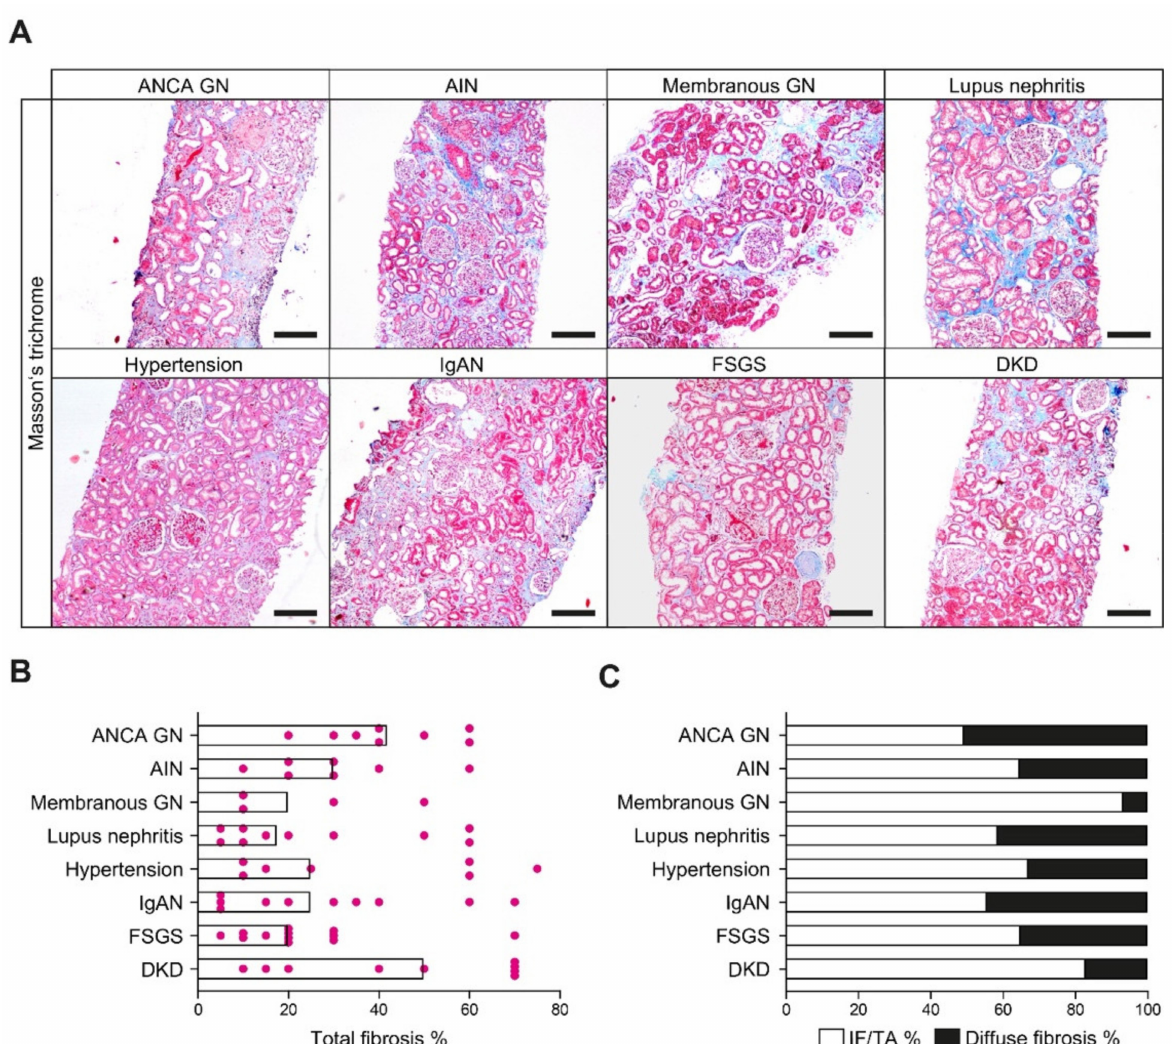
Figure 2. Distribution of focal IF/TA and diffuse fibrosis in various renal pathologies. ( A ) Representative photomicrograph of Masson’s trichrome-stained kidney section in various renal pathologies (scale bars: 200 µ m). ( B ) The scatter dot plots represent the medians with individual data points summarizing the extent of total kidney fibrosis in indicated renal pathologies. ( C ) The bar graph summarizes the fraction of focal IF/TA and diffuse fibrosis relative to total fibrosis in the indicated renal pathologies. Abbreviations: AIN—acute interstitial nephritis; ANCA—antineutrophil cytoplasmic antibody; DKD—diabetic kidney disease; FSGS—focal segmental glomerulosclerosis; GN—glomerulonephritis; IF/TA—interstitial fibrosis/tubular atrophy; IgAN—immunoglobulin A